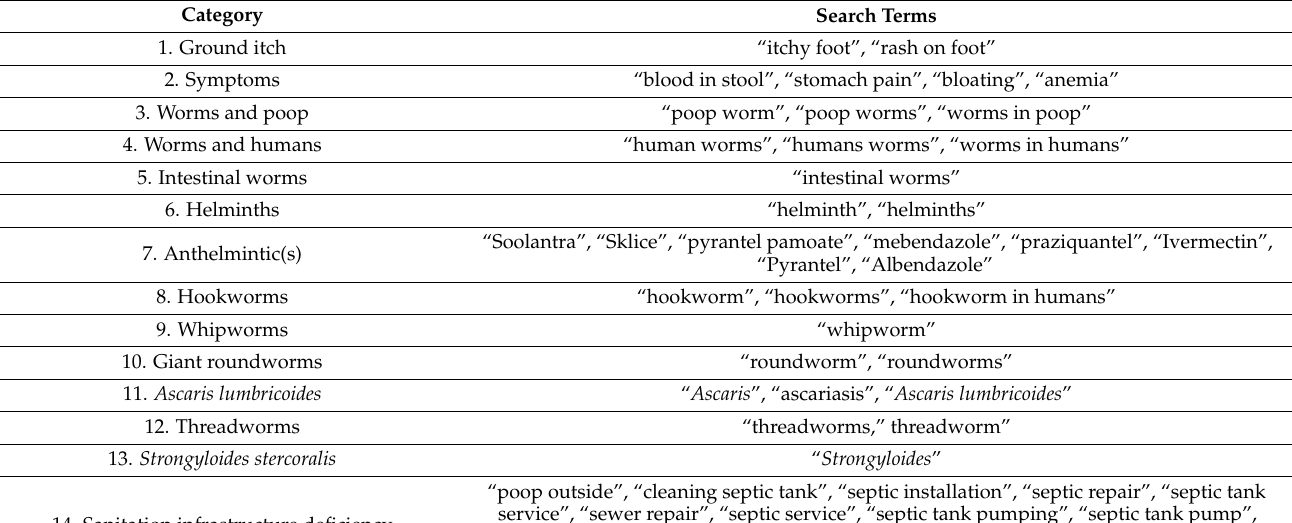
Table 2. Categorization of search terms for spatial